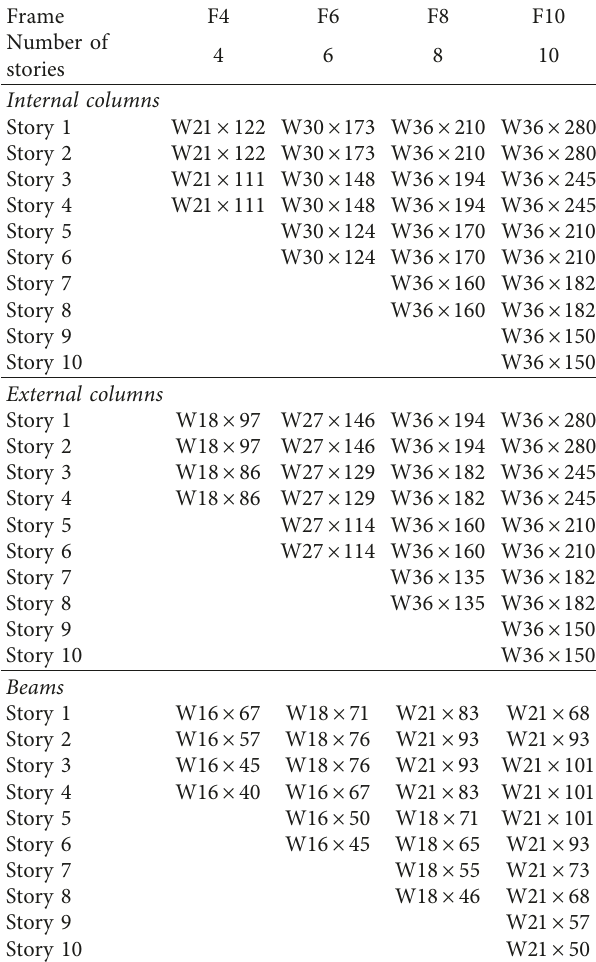
Table 1: Relevant characteristics of the steel frames.